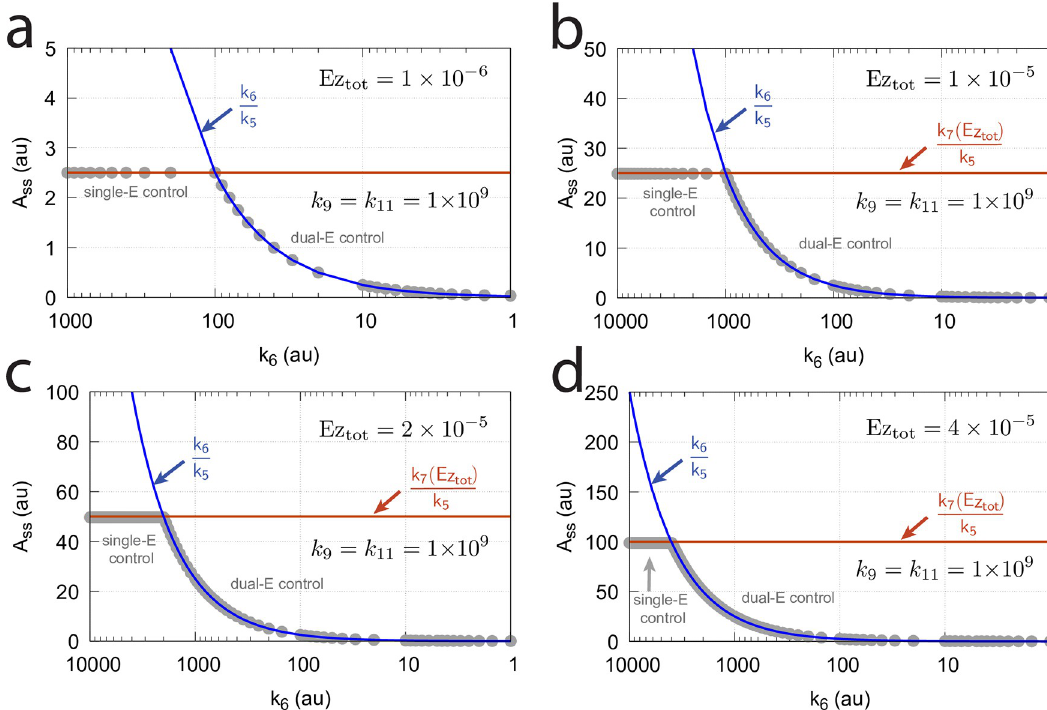
Fig 37. Switch between dual-E and single-E control in the m5 compulsory-order ternary-complex mechanisms ( E 1 binding first to Ez ) as a function of k 6 and total enzyme concentration Ez tot . (a) Ez tot =1 × 10 − 6 . (b) Ez tot =1 × 10 − 5 ; (c) Ez tot =2 × 10 − 5 ; (d) Ez tot =4 × 10 − 5 . Set-points for dual-E and single-E control are indicated in blue and red, respectively. Numerical values are shown as gray filled dots. Rate constants: k 1 =1000.0, k 2 =1.0, k 3 =0.0, k 4 =1.0, k 5 =40.0, k 6 variable, k 7 =1 × 10 8 , k 9 = k 11 =1 × 10 9 , k 10 = k 12 =1 × 10 3 . Initial concentrations: A 0 =1.0, E 1,0 =993.4, E 2,0 =6.67 × 10 − 2 Panel (a): Ez 0 =1 × 10 − 6 , (E 1 � Ez) 0 =0, and (E 1 � Ez � E 2 ) 0 =0. Panel (b): Ez 0 =1 × 10 − 5 , (E 1 � Ez) 0 =0, and (E 1 � Ez � E 2 ) 0 =0. Panel (c): Ez 0 =2 × 10 − 5 , (E 1 � Ez) 0 =0, and (E 1 � Ez � E 2 ) 0 =0. Panel (d): Ez 0 =4 × 10 − 5 , (E 1 � Ez) 0 =0, and (E 1 � Ez � E 2 ) 0 =0. A values were taken after a simulation time of 20000 time ss